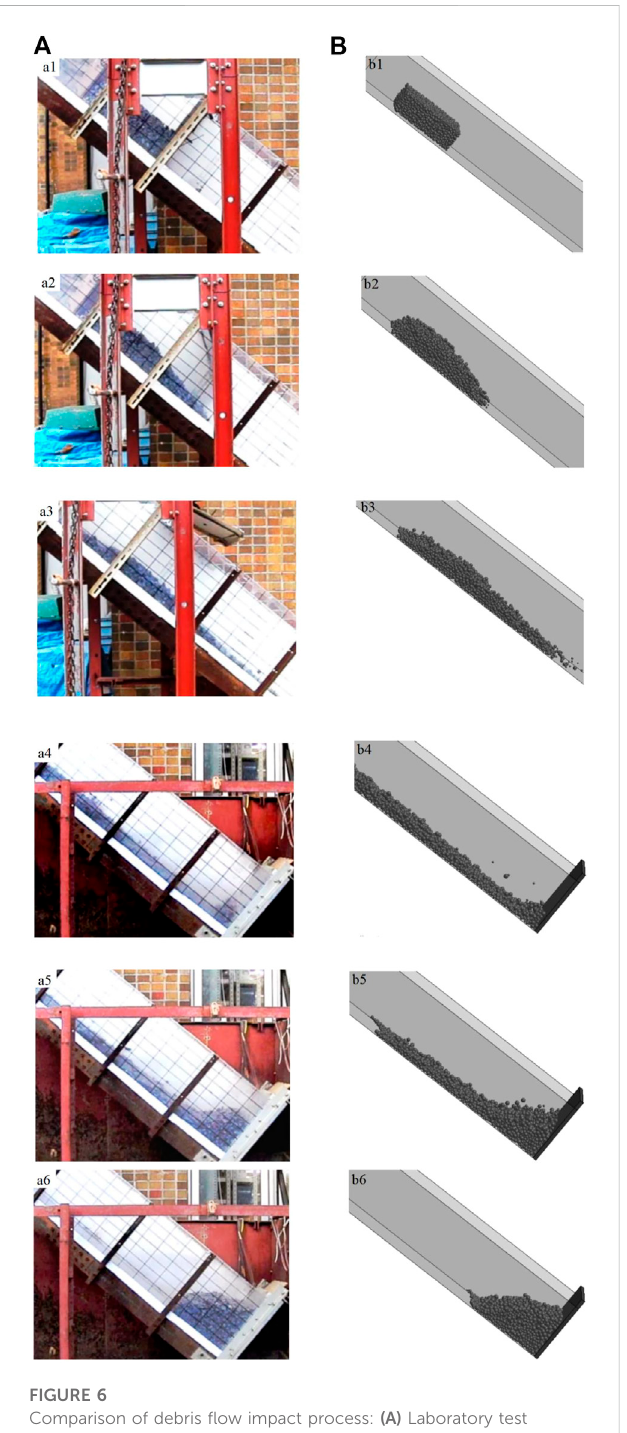
FIGURE 6 Comparison of debris fl ow impact process: (A) Laboratory test Jiang et al. (2013); (B) Numerical simulation results.